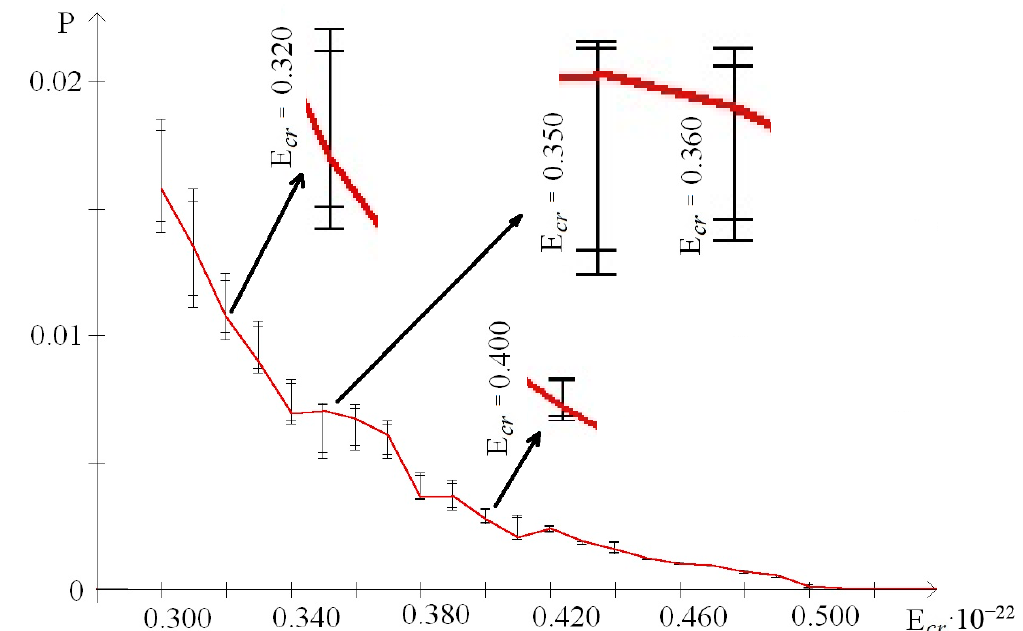
Figure 8. Dynamics of the open state (OS) occurrence in IFNA17 dependent on the H-bond dissociation energy under natural condition and after the single 2 H/ 1 H replacement (with gradation of OS occurrence frequency by Basov–Jimack algorithm). Note: for each H-bond dissociation energy: the 1st cross dash is P i max , the 2nd cross dash is bottom of the range “Maximum”, the 3rd cross dash is top of the range “Minimum”; the 4th cross dash is P i min ; red line is OS occurrence frequency under condition when all hydrogen bonds in DNA are 1 H (P 0